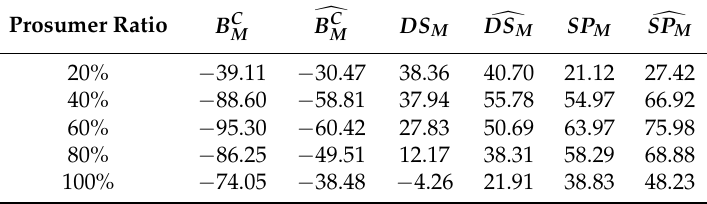
Table 4. Comparison between capped and uncapped results for the setting with imperfect predictions without storage for M in £. At the end of the period, both B C under the uncapped approach, increasing the prosumer ratio decreases DS M until it becomes negative with 100% prosumers, whereas the capped approach maintains community surplus, and results in higher (cid:100) DS M and (cid:100) SP M .